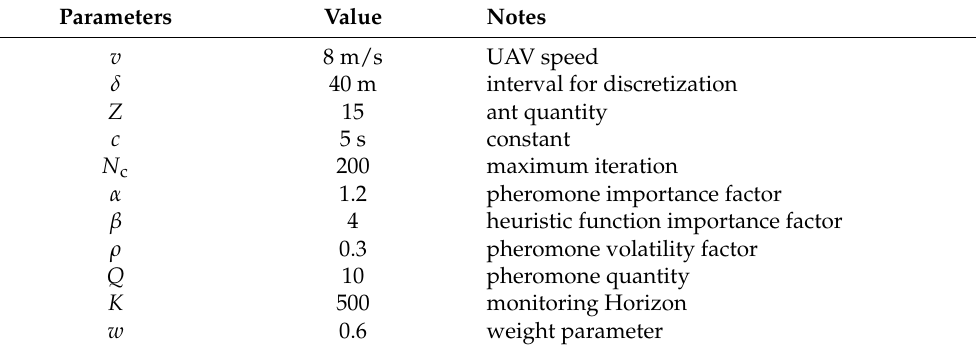
Figure 3. Discretization of a completely connected graph. Table 1. Simulation parameters.